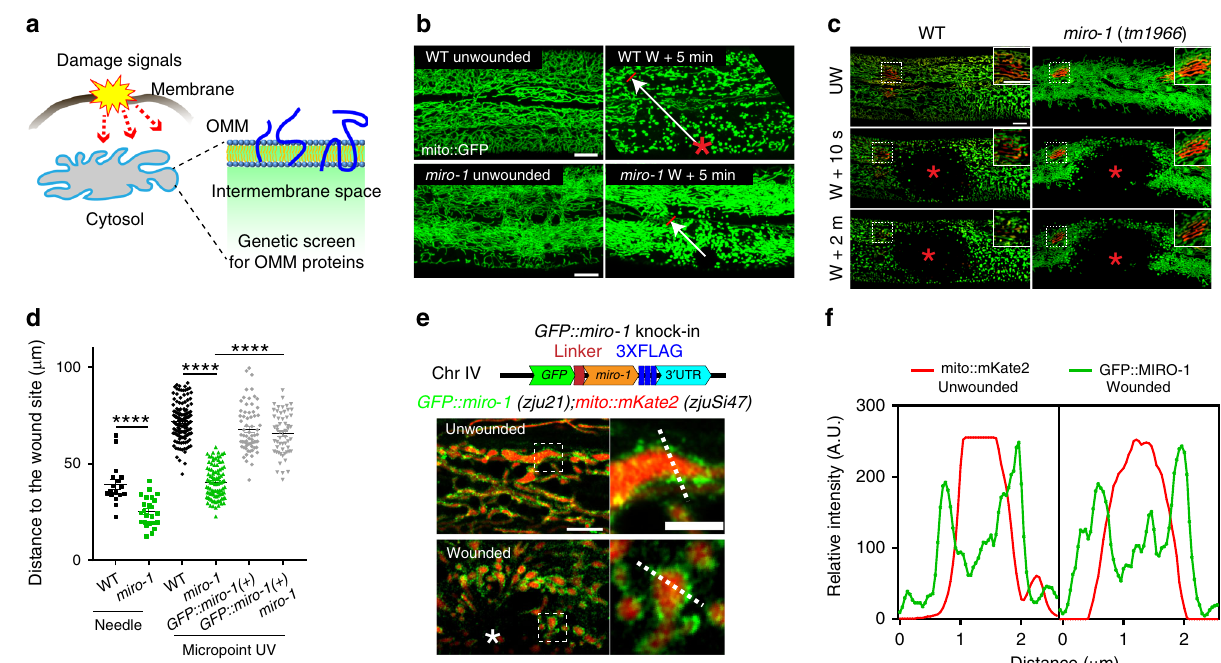
Fig. 3 WIMF is dependent on mitochondrial Rho GTPase MIRO-1. a Diagram of a genetic screen for outer mitochondrial membrane (OMM) proteins involved in WIMF. The candidate genes and mitochondrial morphological phenotype before and after wounding are listed in Supplementary Table 4. b Representative confocal images of epidermal mitochondria before and after needle wounding. N = 5 independent experiments. Arrows indicate the farthest extent of fragmented mitochondria from the wound site, which we used for the quantitation of distance of mitochondrial fragmentation. c Representative confocal images of epidermal mitochondria before and after Micropoint UV laser wounding (see also Supplementary Movie 6). Mitochondria were labeled by P col-19-mito::dendra2(juSi271) ( b , c ). Red mitochondria were photo-converted with a 405-nm laser. N = 3 independent experiments. Note WIMF is restricted to the injury site and does not spread to adjacent mitochondria in miro-1(tm1966) mutants. Scale bars ( b , c ), 10 μ m. d Quantitation of the distance of fragmented mitochondria to the wound site after needle or Micropoint UV wounding in miro-1(tm1966) and rescued animals (WT-needle, n = 17; miro-1 -needle, n = 24; WT-laser, n = 144; miro-1 -laser, n = 99; GFP:: miro-1( + ) -laser, n = 68; miro-1; GFP:: miro-1( + ) -laser, n = 56 animals). Typically, we generated 20 arrows, as shown in panel b and averaged for each animal, see detail in methods. Bars indicate mean ± SEM. **** P < 0.0001, Two-tailed unpaired t -test. Source data are provided as a Source Data fi le. e Localization of GFP::MIRO-1 before and after needle wounding. Top, diagram of GFP::miro-1 knock-in strategy. Bottom, representative confocal image of Pcol-19-GFP::miro-1(zju21); Pcol-19-mito::mKate2(zjuSi47) (see also Supplementary Movie 7). GFP::MIRO-1 is localized around mito::mKate2 and was remained at the wounding site immediately after wounding. Scale bar, 5 μ m and 2 μ m (zoom-in). N = 2 independent experiments. f Fluorescence pro fi les from line scan 1 and 2 illustrate the presence of GFP::MIRO-1 on a section of the mitochondrial membrane before and after needle wounding. A.U. arbitrary units. Images representative of fi ve animals. Note, the GFP signal surrounds the mitochondrial matrix mito::mKate2